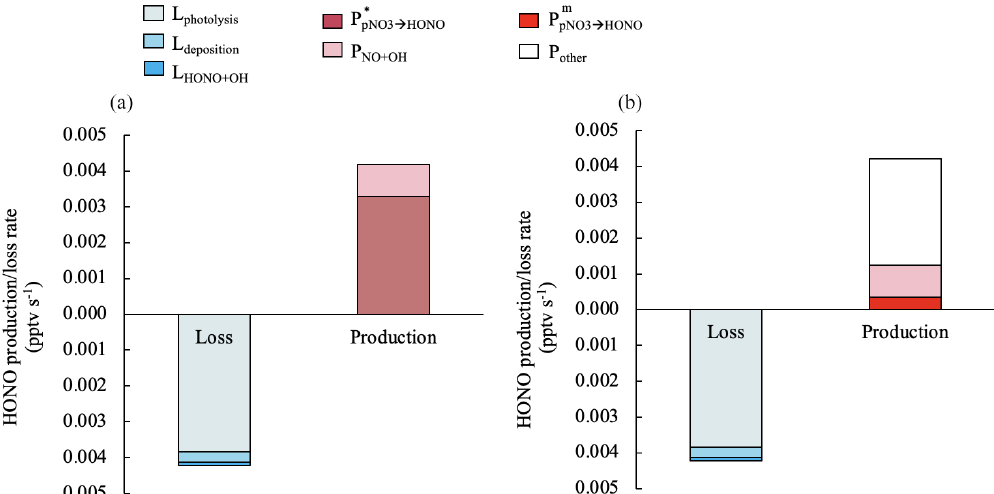
Figure 6. Median values for the production and loss rates of HONO contributed by different processes in clean marine air from 10:00 to 15:00. The HONO production rate by NO 2 heterogeneous reactions on aerosols contributed to < 0.2% of the HONO production budget and therefore is not displayed in this figure. For the HONO production rate via pNO 3 photolysis, P ∗ in (a) was estimated with a pNO 3 → HONO constant EF ∗ value of 29, and P m in (b) was estimated with the measured enhancement factor EF m pNO 3 → HONO